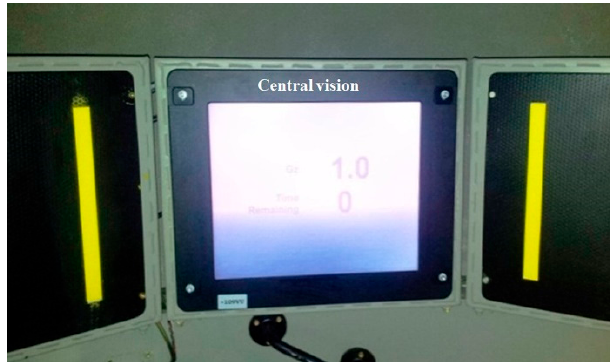
Figure 5. Light bars as the visual reference.